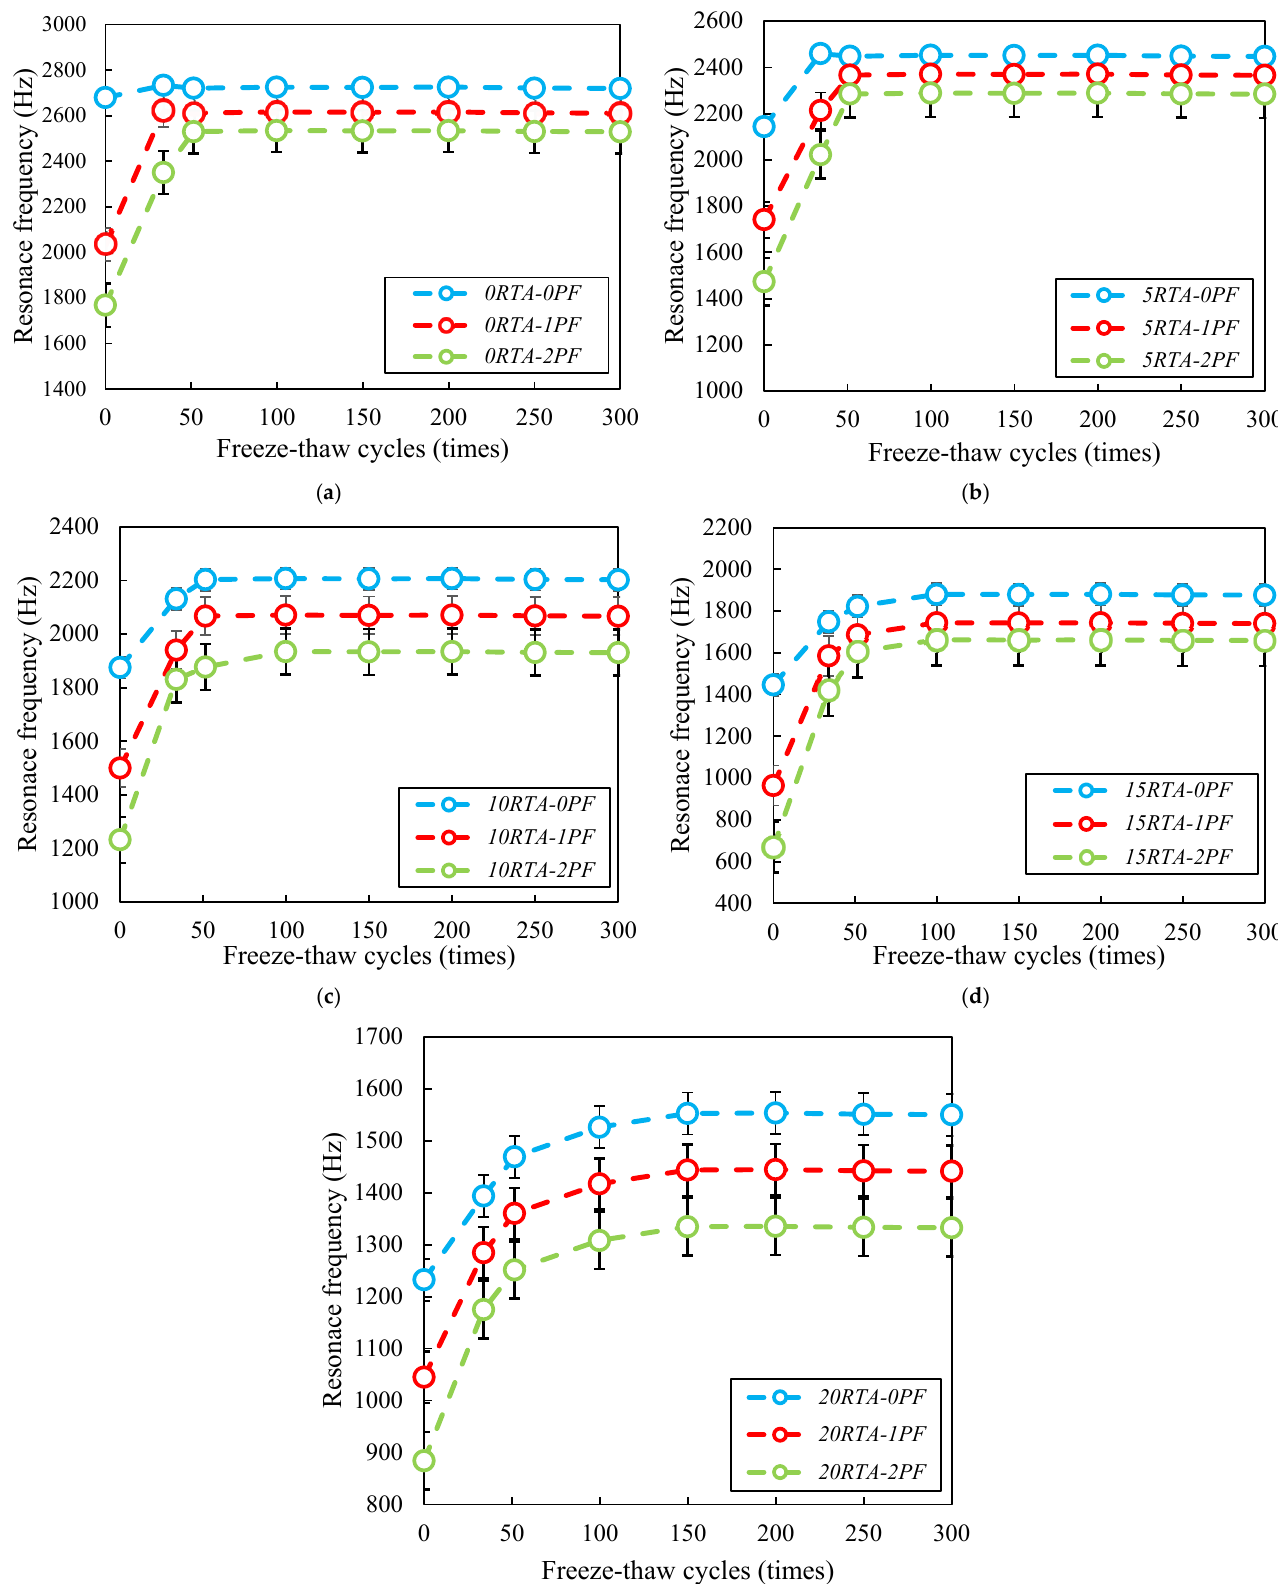
Figure 21. Influence of PF and RTA on the frequency: ( a ) Without RTA; ( b ) 5% RTA; ( c ) 10% RTA; ( d ) 15% RTA and; ( e ) 20% RTA.